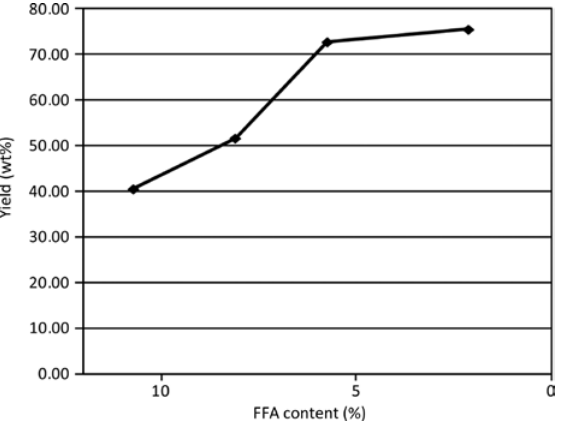
Figure 6: Influence of free fatty acid (FFA) concentration on biodiesel yield (T = 65 ° C, t = 45 min, 0.5 wt% KOH).